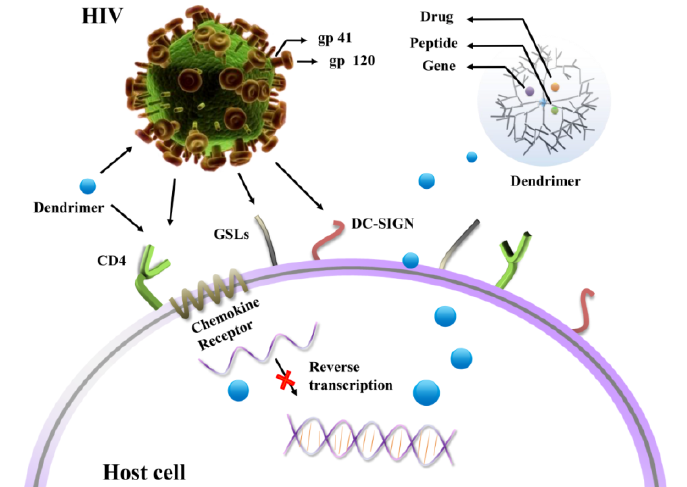
Figure 1. Dendrimers as potential agents and non-viral vectors of drug/gene delivery system for HIV